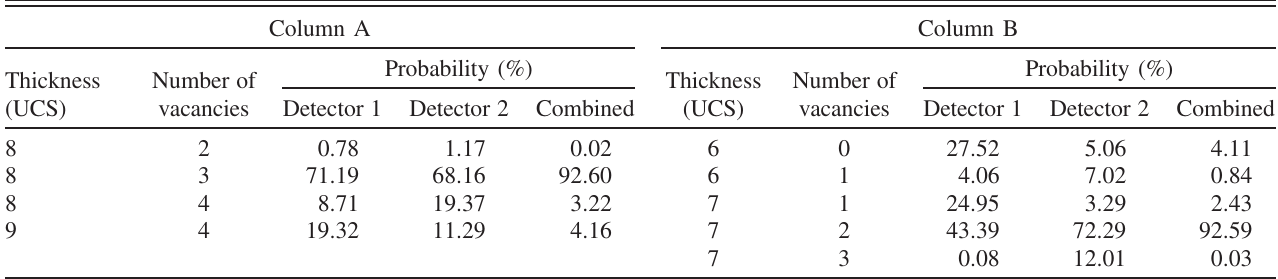
TABLE I. Probability of Sr vacancy configurations. Probabilities of determining the correct number of Sr vacancies in column A and B using the different detector information: detector 1; detector 2; combined detector. Configurations with probabilities of less than 0.01% are not